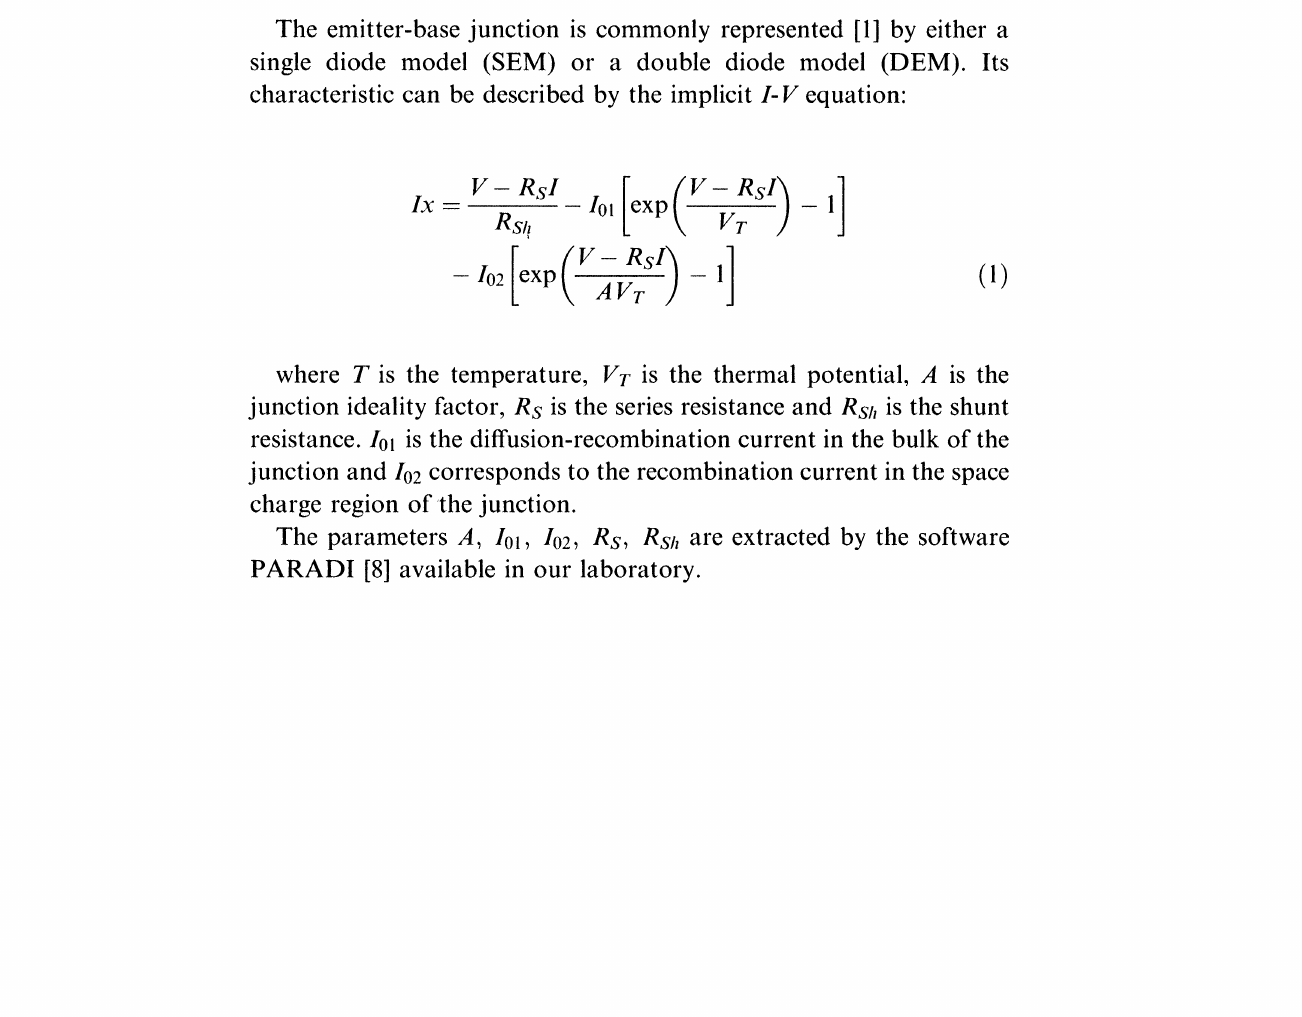
FIGURE Experimental setup: electrical stress of a n+-p-n transistor.